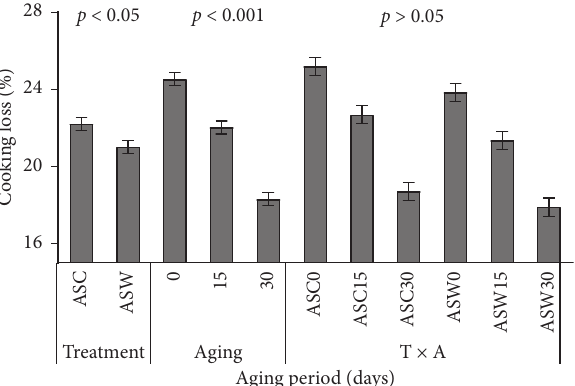
Figure 1: Effect of cooking loss (%) in dry-aged, sous vide-cooked whey-fed pork loin. (1) ASC, dry-aged, sous vide-cooked control diet pork loin; ASW, dry-aged, sous vide-cooked, whey-fed pork loin; ASC0, 0d dry-aged, sous vide-cooked control diet pork loin; ASC15, 15 d dry- aged, sous vide-cooked control diet pork loin; ASC30, 30d dry-aged, sous vide-cooked control diet pork loin; ASW0, 0d dry-aged, sous vide-cooked whey-fed pork loin; ASW15, 15 d dry-aged, sous vide-cooked whey-fed pork loin; ASW30, 30d dry-aged, sous vide-cooked whey-fed pork loin. (2) T × A treatment × aging interaction. Error bars indicate